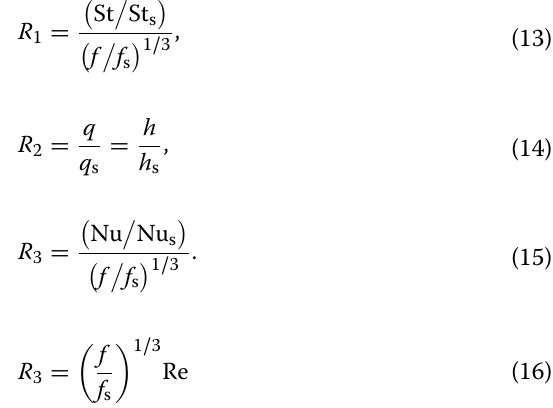
using twisted tape With an increase in pressure drop, twisted tape increases the heat transfer coefficient. Complete-length twisted tape, short length twisted tape, full length twisted tape with varying pitch, reduced width twisted tape, and regularly spaced twisted tape are all examples Table 2 of twisted tape have already been configured. Different researchers have used different output ratios for multi-tube heat exchangers